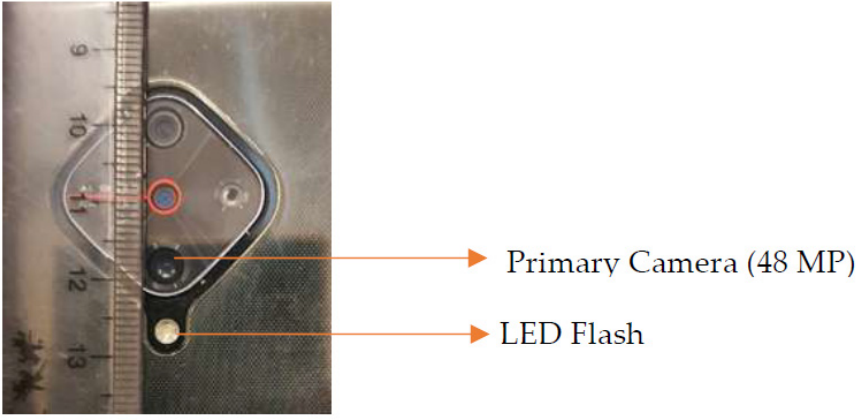
Figure 1. Photograph demonstrating the arrangement of primary camera lens and ‘LED’ flash on the smart